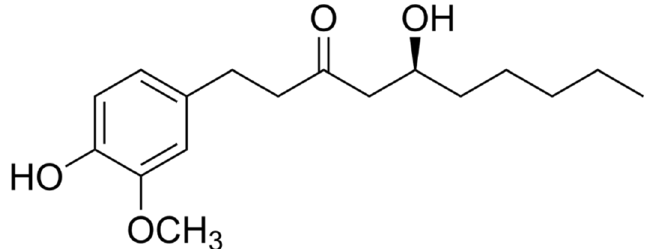
Figure 3. The chemical structure of gingerol. This polyphenol can be generally found as a pungent yellow oil in the ginger rhizome, which can be uniquely identified as a low-melting point crystalline solid [47].